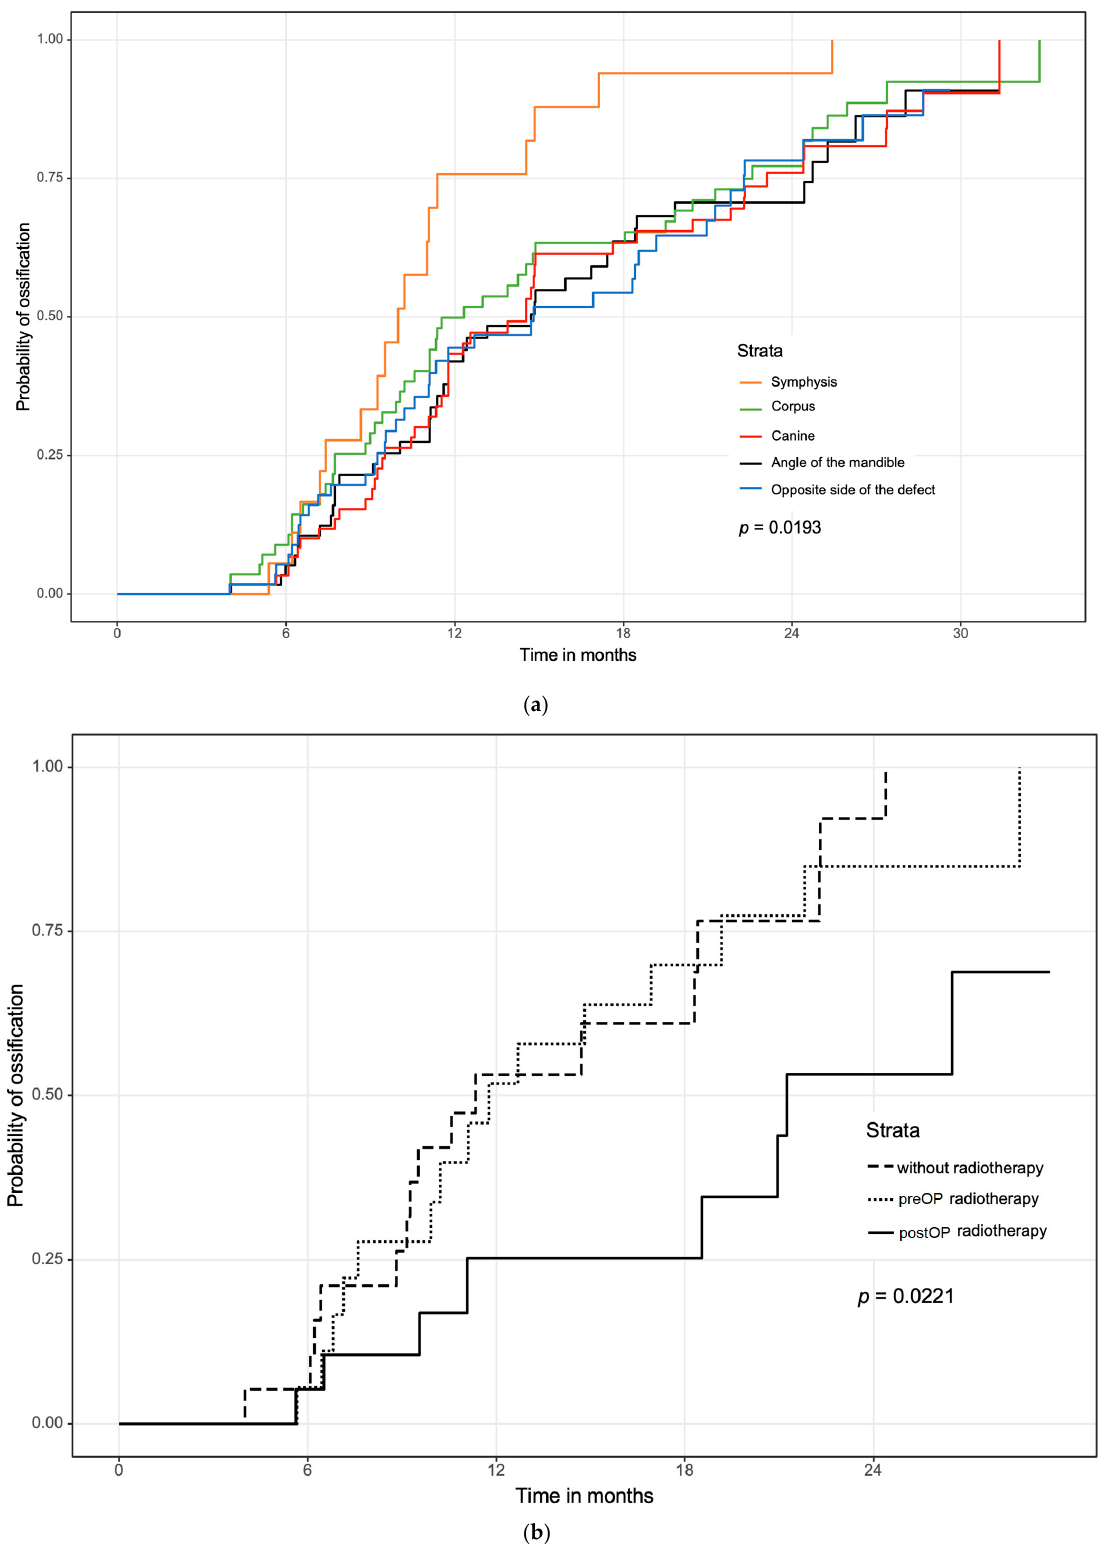
Figure 4. ( a ) Overall locations of the mandible. Reconstructions of the maxilla were excluded in this figure due to a lack of data. ( b ) Separate evaluation of the contralateral (opposite) side. Significantly worse ossification in the postORT group. Regarding contact localizations and noRT, pre- or postoperative radiation therapy, only the region of the corpus and the opposite side (Figure 4b) showed significant results between the subgroups. In the region of the corpus, the nonirradiated patients showed significantly faster complete ossification compared to patients with postoperative ( p < 0.001) and preoperative ( p = 0.009) radiation therapy. Between the pre- and postoperative subgroups, no significant difference could be observed. The opposite side was defined as the contact point contralateral to the main defect and also contralateral to the target volume in case of irradiation. In comparison to the postORT subgroup, the noRT ( p = 0.007) and the preORT ( p = 0.036) subgroups showed significantly faster complete ossification at the contralateral side. 3.4. Influence of Initial Contact between the Bone Segments on Ossification and Analysis of Multiple Variables Regarding Ossification A good initial contact between the different bone segments led to significantly faster complete ossification than a modest contact ( p < 0.001). The median for complete ossification at no initial contact was 448 (IQR 349 – 748) days, 346 (IQR 275 – 520) days for moderate initial contact and 334 (IQR 225 – 533) days for good initial contact. Moreover, age and gender showed no significant influence on ossification, while smoking showed a significant adverse influence on the ossification of microvascular reconstruction in the head and neck region (HR (95% CI), 1.48 (1.12; 1.95), p = 0.006).